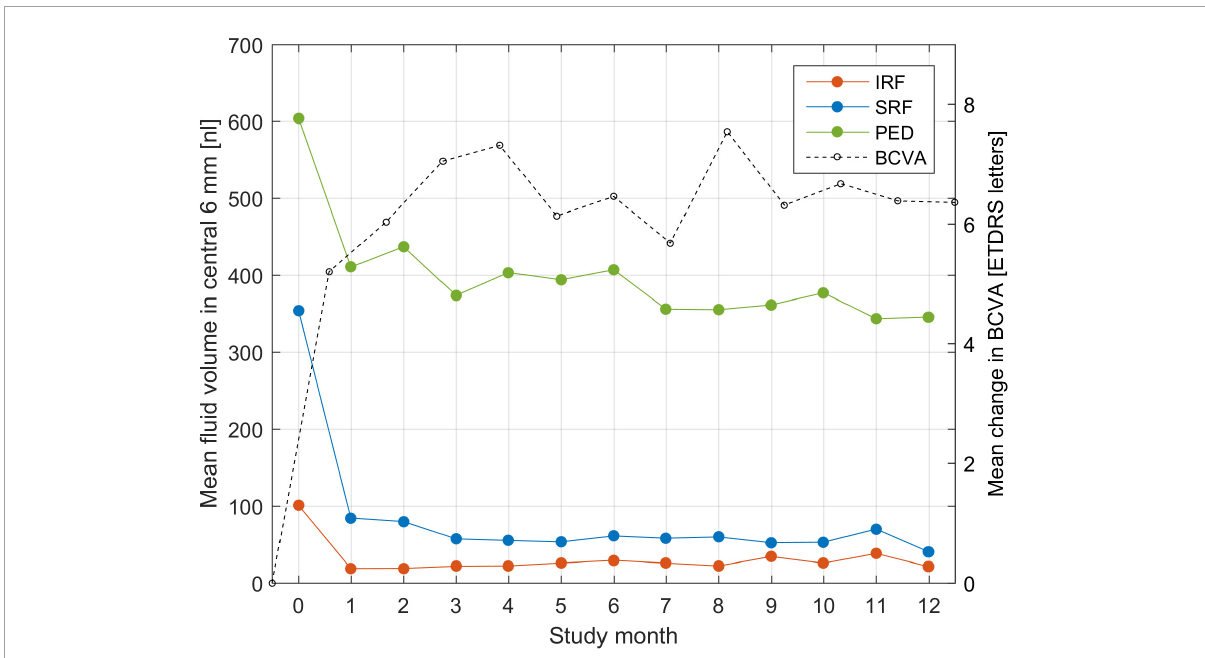
FIGURE2 Mean fluid volume in the central 6-mm during the course of T&E treatment for each of the three fluid types: intraretinal (IRF), subretinal (SRF) and sub-RPE (PED). Fluid volumes are expressed in nanoliters (nl) and put in correspondence with the mean change in BCVA from baseline.